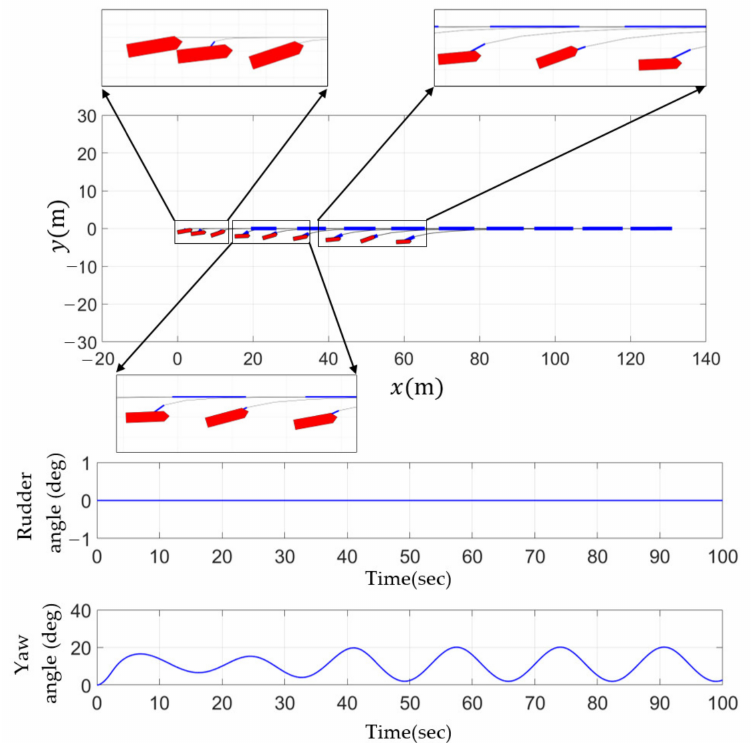
Figure 15. Simulation results without yaw control at point marked with a